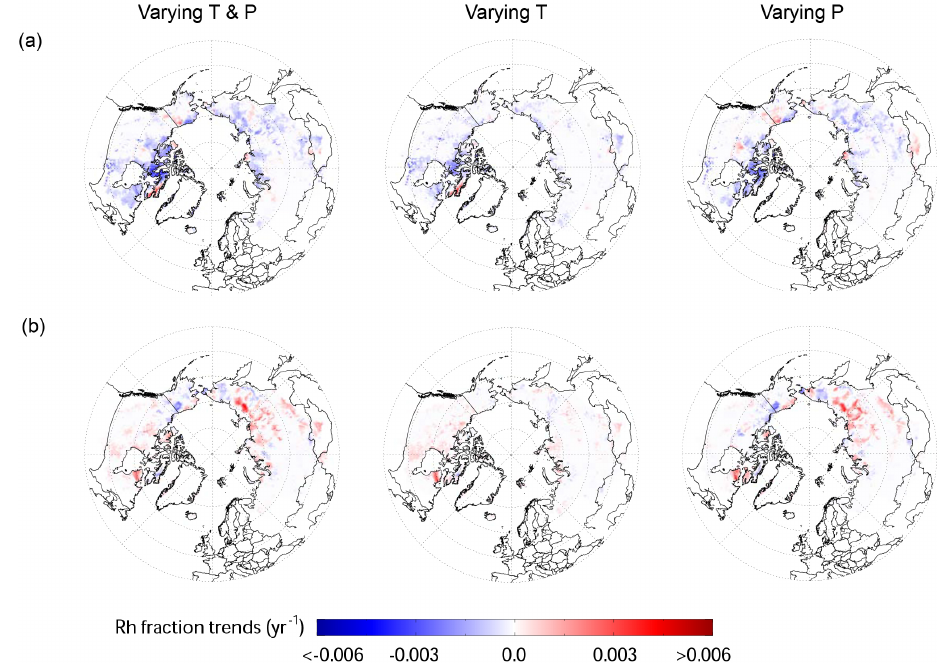
Figure 9. Similar to Fig. 8 but for simulated trends (unit: yr − 1 ) of the warm-season (May–October) soil heterotrophic respiration ( R h ) contribution (i.e., R h fraction) from (a) surface (0–0.2m) and (b) deep (0.5–3.0m) soil carbon pools for the three sensitivity experiments using different surface meteorology configurations, i.e., varying temperature ( T ) and precipitation ( P ) inputs, from 1982 to